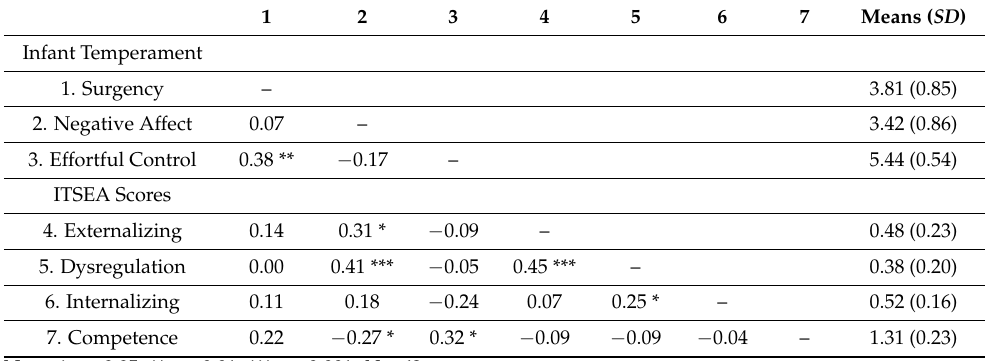
Table 4. Descriptive Statistics and Intercorrelations of Infant Temperament and ITSEA